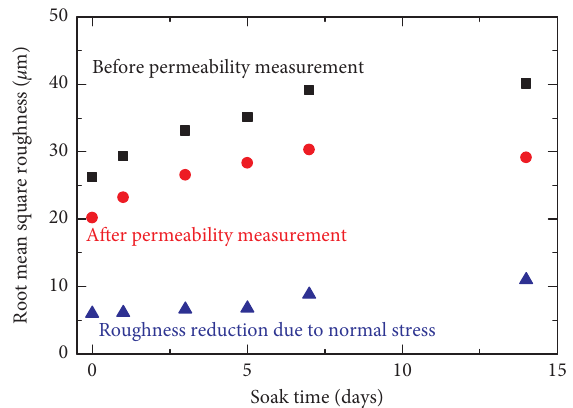
Figure 8: The fracture surface roughness (root mean square roughness) evolution before and after permeability measurement